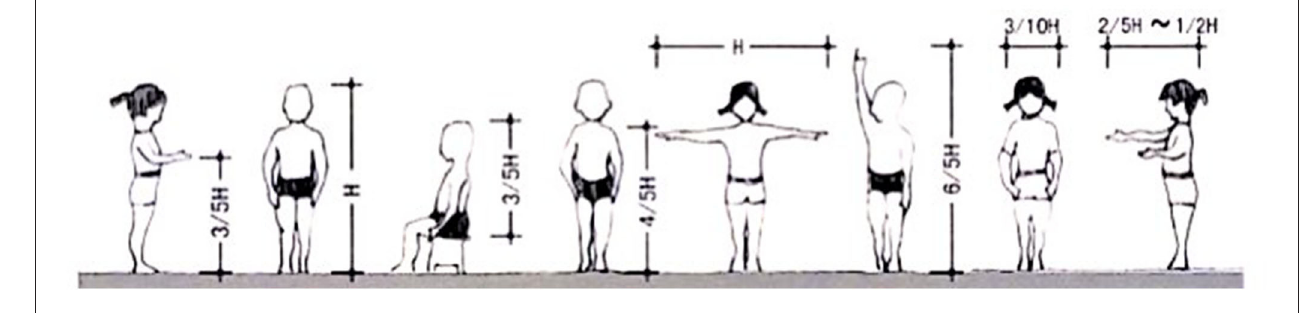
FIGURE 2 | Child scale.